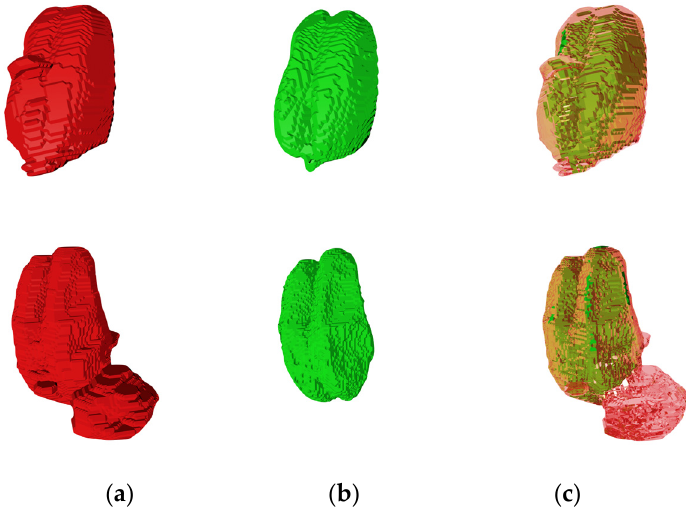
Figure 17. Spike treatment No. 1172 (upper one) and No. 1188 (lower one) contain one grain but some background too. The green grain is detected by our method, the red one is from Hughes. We can see that their grain is much bigger than actual value, which cause the precision loss.